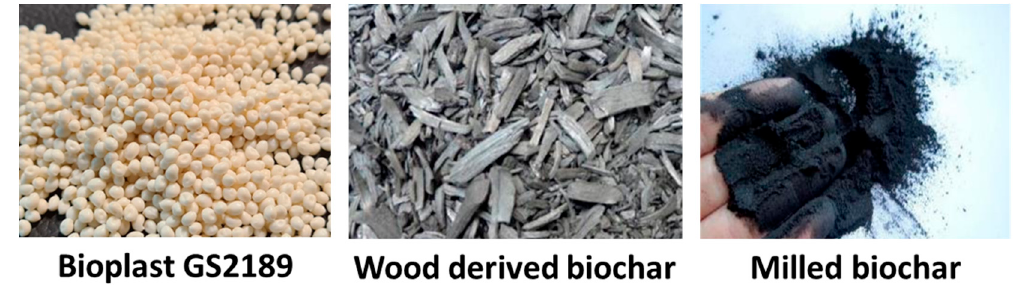
Figure 1. Bioplast GS2189 granules and wood-derived biochar.